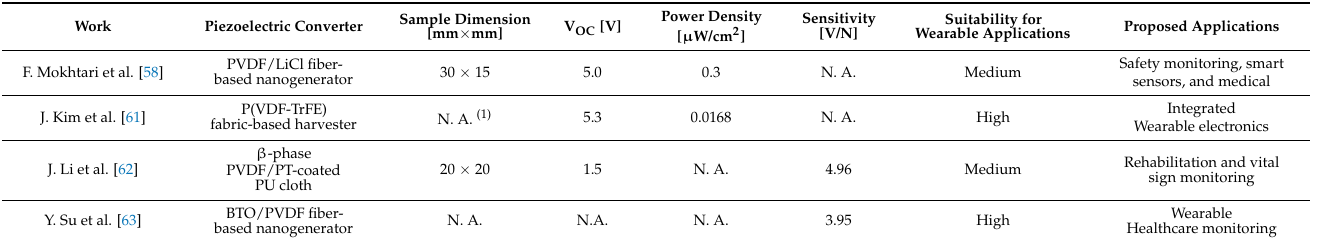
Table 3. Comparative table of piezoelectric wearable-based energy